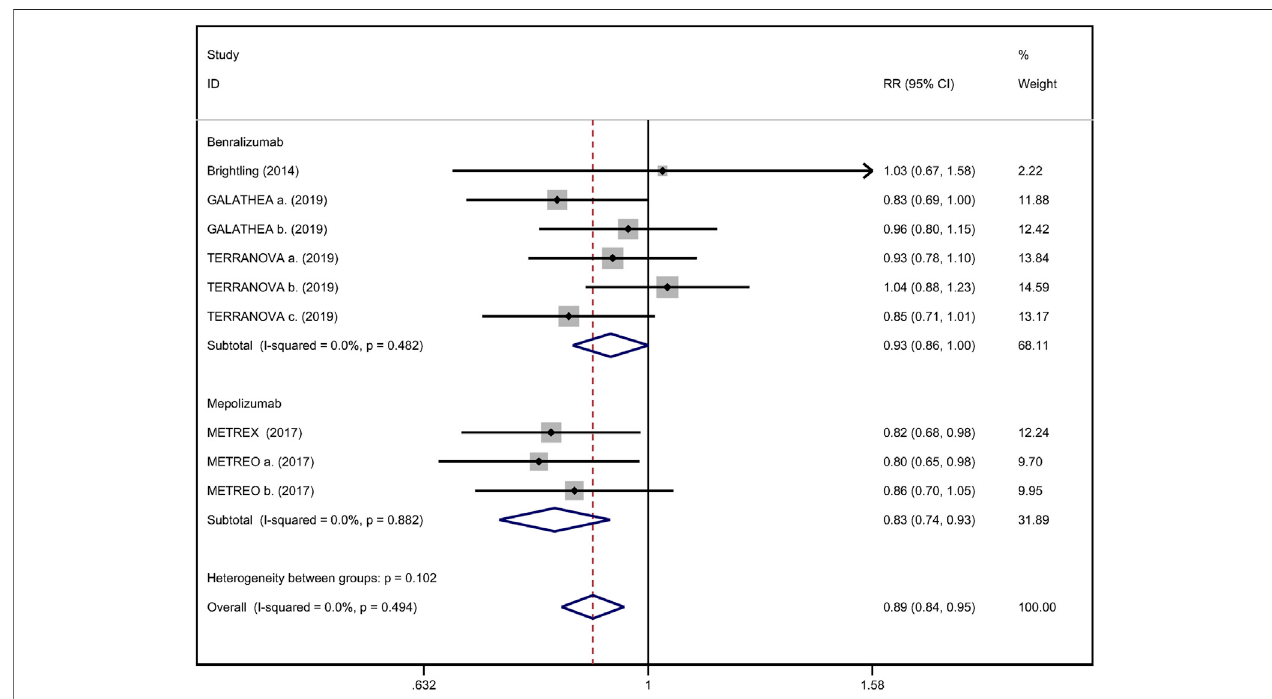
FIGURE 2 | Forest plot of annual acute exacerbation rates in eosinophilic COPD patients with anti-IL-5 therapy vs. placebo.